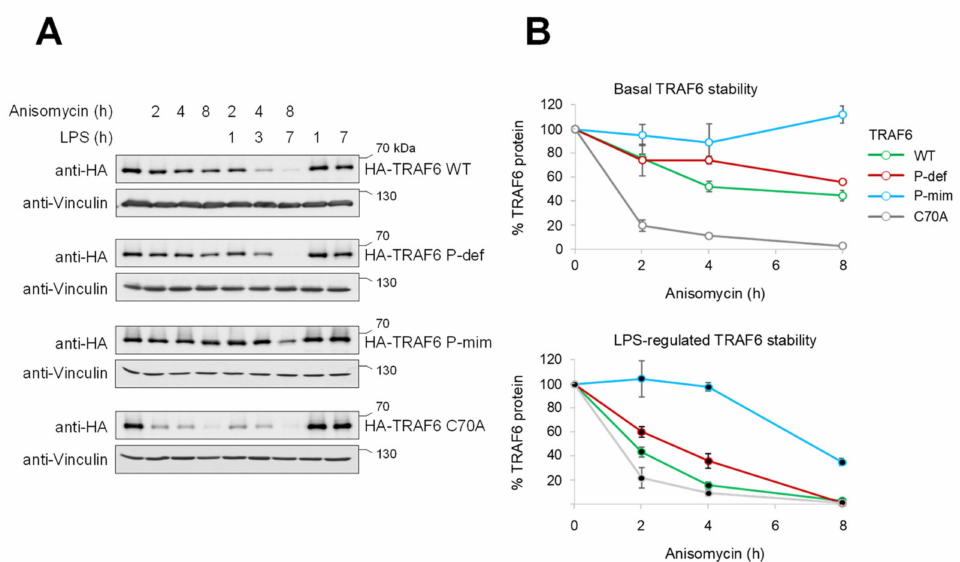
Figure 4. Analysis of LPS/Anisomycin-dependent TRAF6 degradation. ( A ) The indicated cell lines were incubated with Anisomycin either alone or in combination with LPS for the indicated periods. Cell extracts were prepared and analyzed for expression of the proteins, as shown. ( B ) Triplicates of the Western blots displayed in ( A ) were used for protein quantification using the ChemiDoc Imaging System. Relative protein amounts were normalized to Actin levels, and TRAF6 expression in untreated cells was arbitrarily set to 100%; the error bars show standard